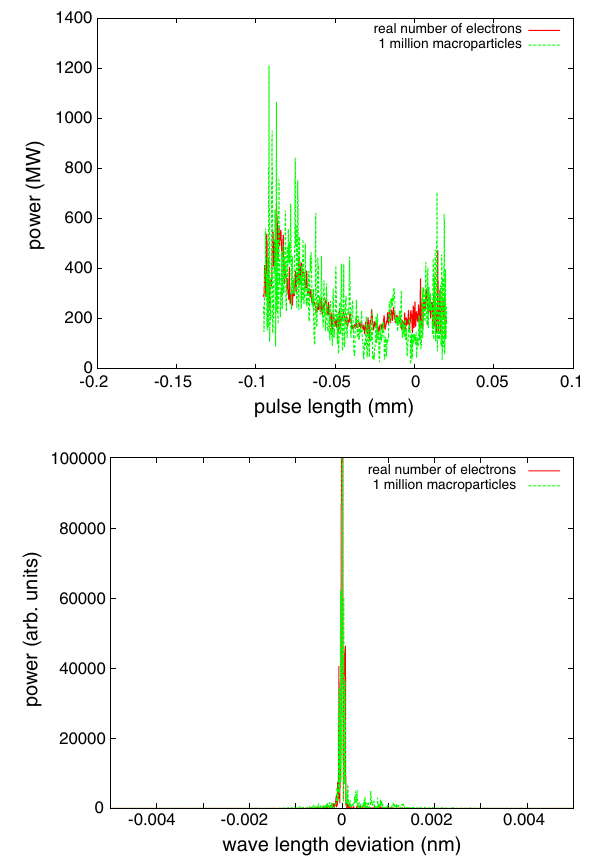
FIG. 16. Temporal (top) and spectral (bottom) profiles of the 1 nm x-ray radiation at 41 m undulator location in the self-seeded FEL scheme with the real number of electrons (red) and the one million macroparticle simulations